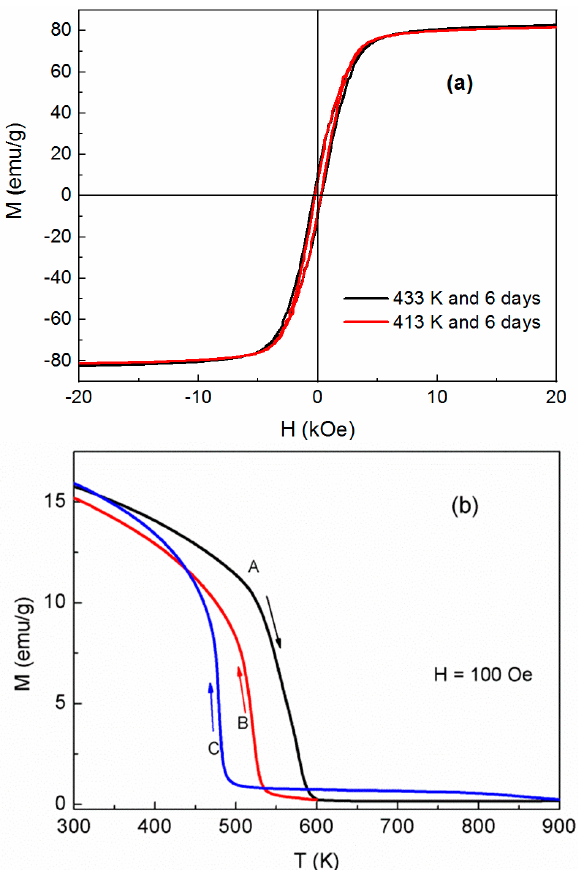
Figure 6. ( a ) Magnetic hysteresis loops of the α″ -Fe 16 N 2 @C nanocones synthesized at 433 K for six days and at 413 K for six days, respectively. ( b ) Temperature dependence of magnetization of the α″ -Fe 16 N 2 @C nanocones synthesized at 433 K and six days in (A) a warming process between 300 and 900 K and the cooling processes from different temperature of (B) 600 K and (C) 900 K, respectively, to 300 K.